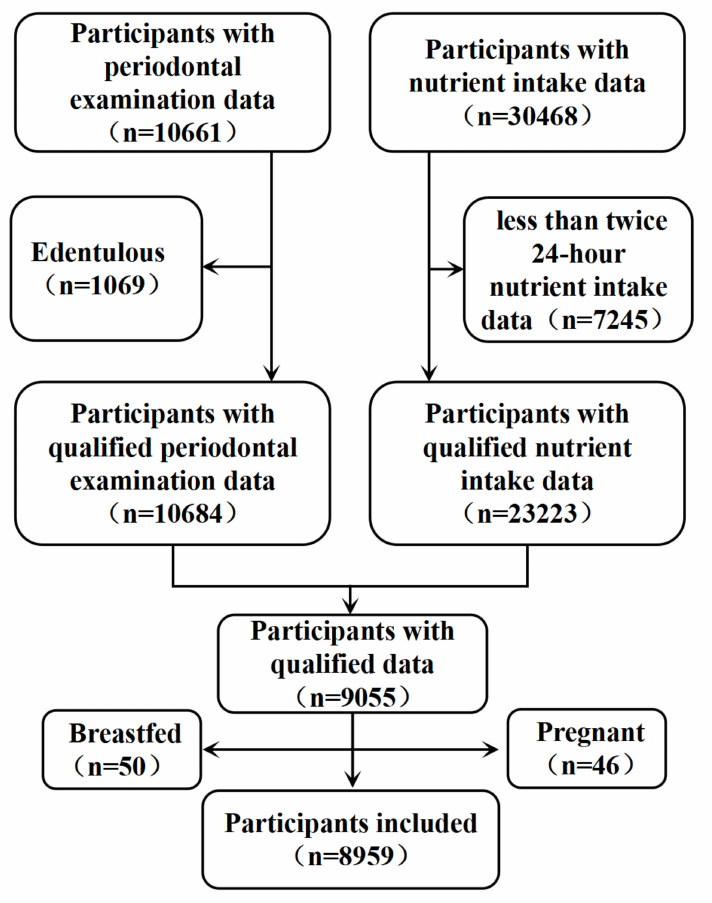
Figure 1. Flowchart for screening